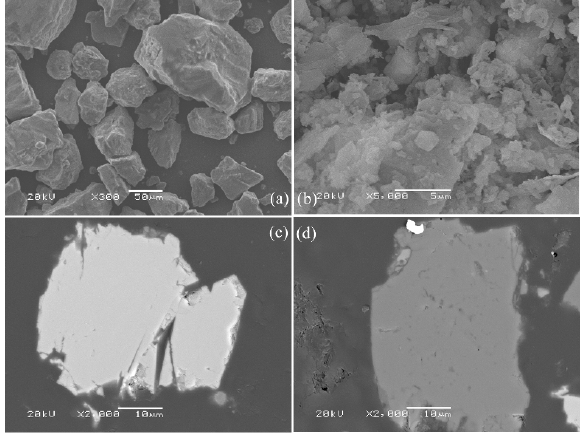
Figure 11. Arrhenius curve for the dissolution of hemimorphite.